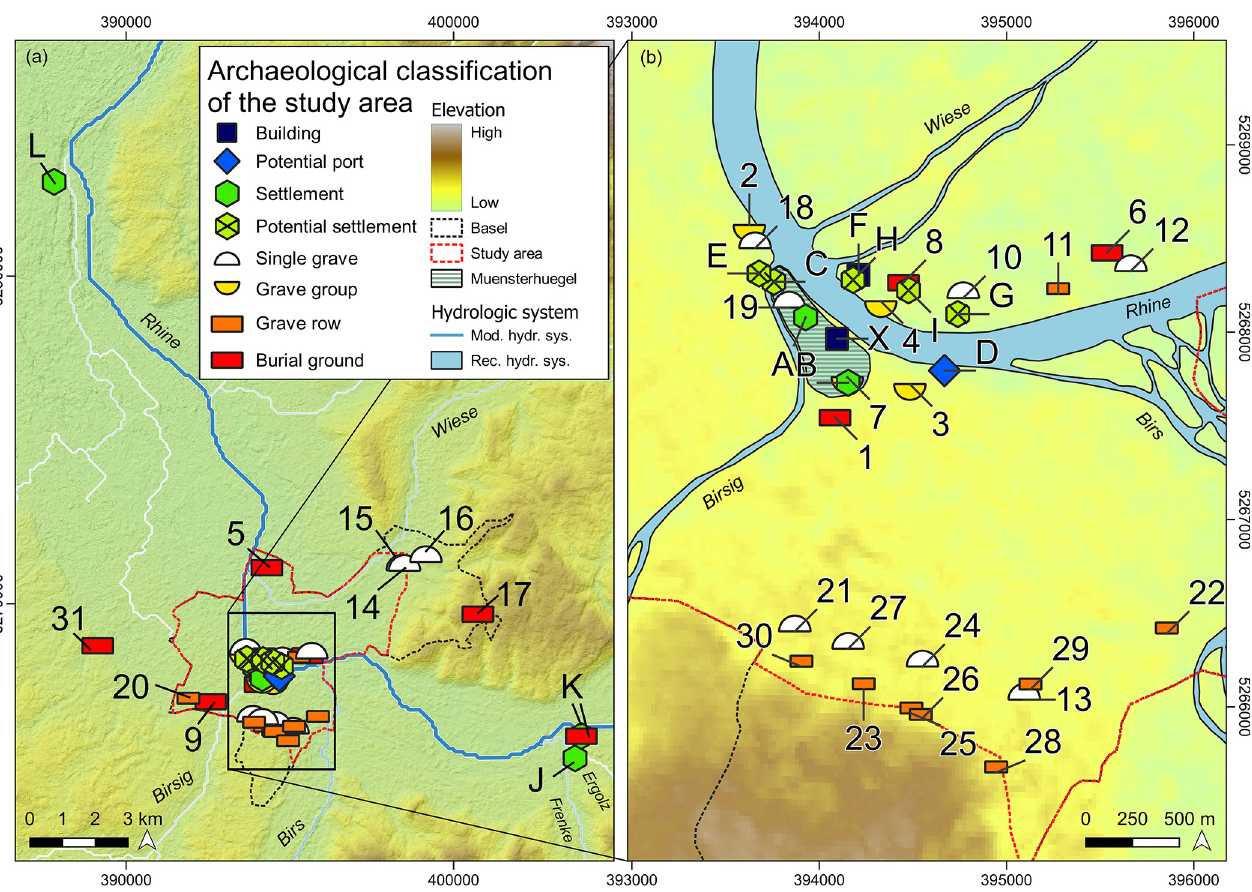
Fig 1. Type of the archaeological record in the study area and the complementary region at Basel. (see Table 1 for type, name, and chronological differentiation) a) complementary region coverage with topographic features and modern hydrologic system; b) zoom into the archaeological settings at Basel with topographic elements and reconstructed potential streamflow characteristics [75]. Images are for illustrative purpose only. Data source: hydrologic streamflow derived from Open Street Map (OSM, https://wiki.openstreetmap.org/wiki/Main_Page) data under https://creativecommons.org/licenses/by-sa/2. 0/, last accessed 3 rd of November 2022). Administrative boundaries were individually redrawn using GIS software. Reconstructed streamflow was redrawn from Rentzel et al. (2015) (see ref. 75). Digital elevation data derived from the USGS ( GMTED2010 , Global Multi-resolution Terrain Elevation Data